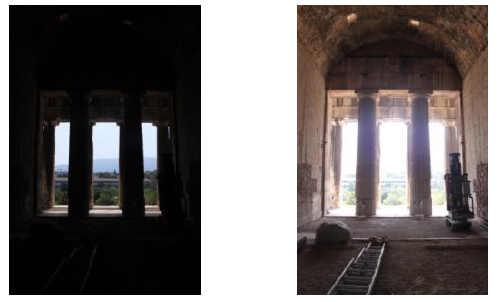
Figure 1: Example of adverse lighting